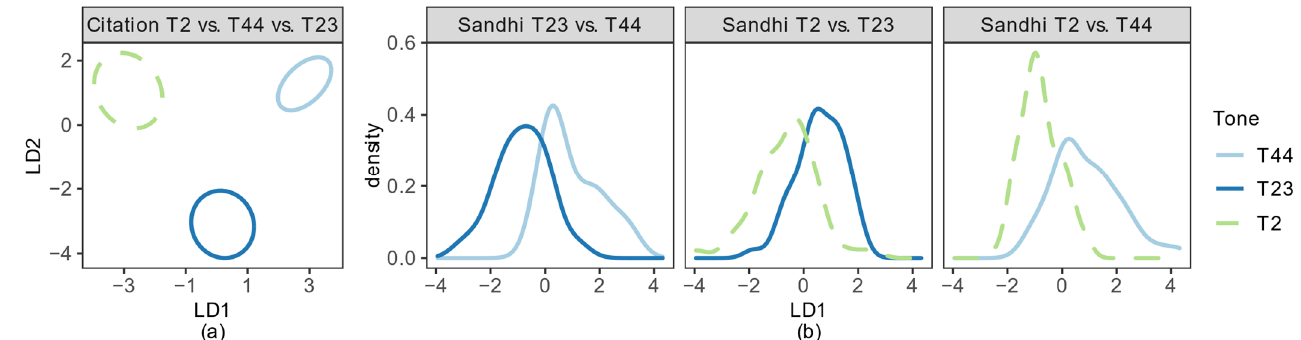
Figure 10. ( a ) is the first and second linear discriminant score (LD1 and LD2) distribution of T2 vs. T44 vs. T23 in citation forms. The ellipses represent 50% confidence intervals around the mean of each group. ( b ) is the LD1 distribution of T23 vs. T44, T2 vs. T23, and T2 vs. T44 in sandhi forms, respectively. LD1 and LD2 are from the models without cross-validation.